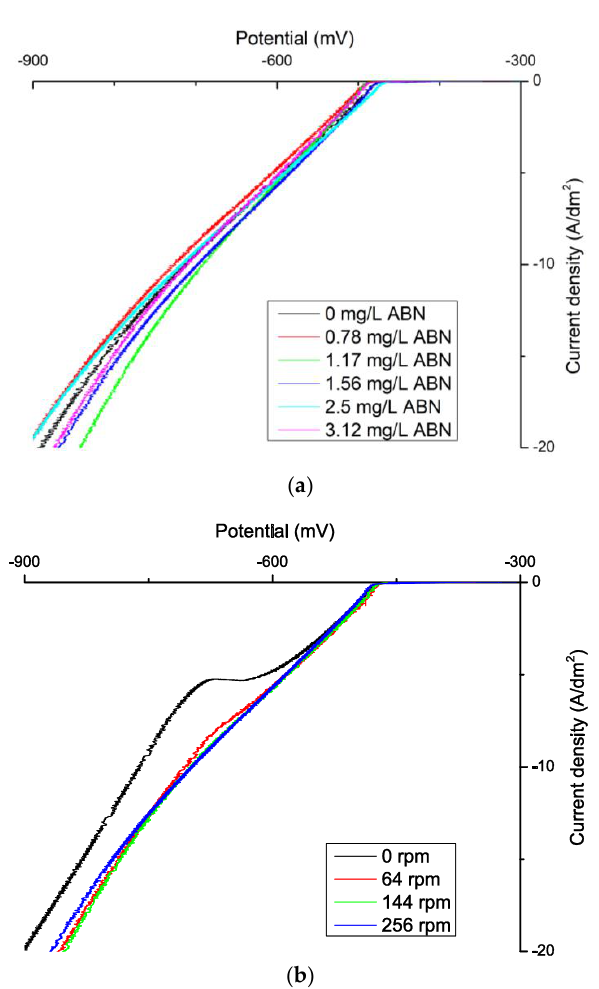
Figure 6. Polarization curves measured with the rotating disk electrode (RDE) in the MSA electrolyte: ( a ) convection kept constant at 256 rpm and varying the ABN content. The addition of ABN has no visible influence on the cathodic current. ( b ) with the optimum concentration of ABN 1.56 mg/L for the chloride based electrolyte and varying the electrolyte convection by increasing the electrode rotation. Similarly, to the chloride based electrolyte, current density is increased when the convection of the electrolyte is introduced. However, the limiting current density plateau is no longer visible.